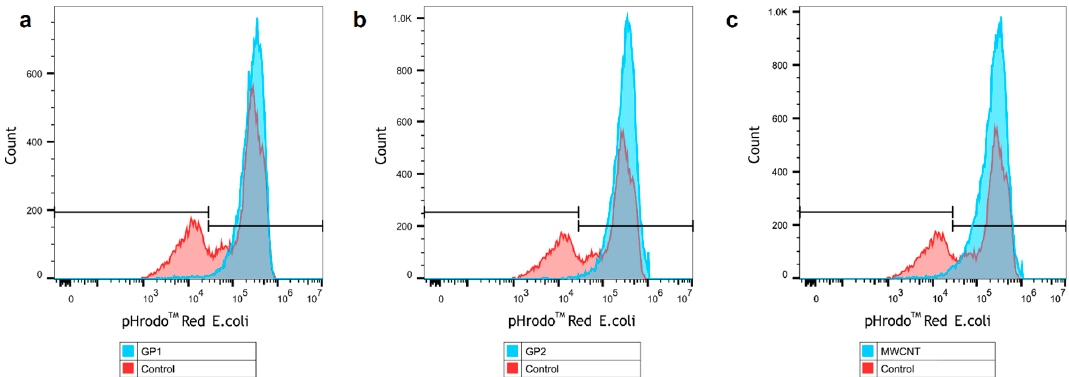
Figure 6. Representative flow cytometry images of phagocyted EC (200 µ g/mL). Comparison of primary monocytes pre-treated by ( a ) GP1, ( b ) GP2, ( c ) MWCNTs (blue) and control without C-BNMs pre-treatment (red).